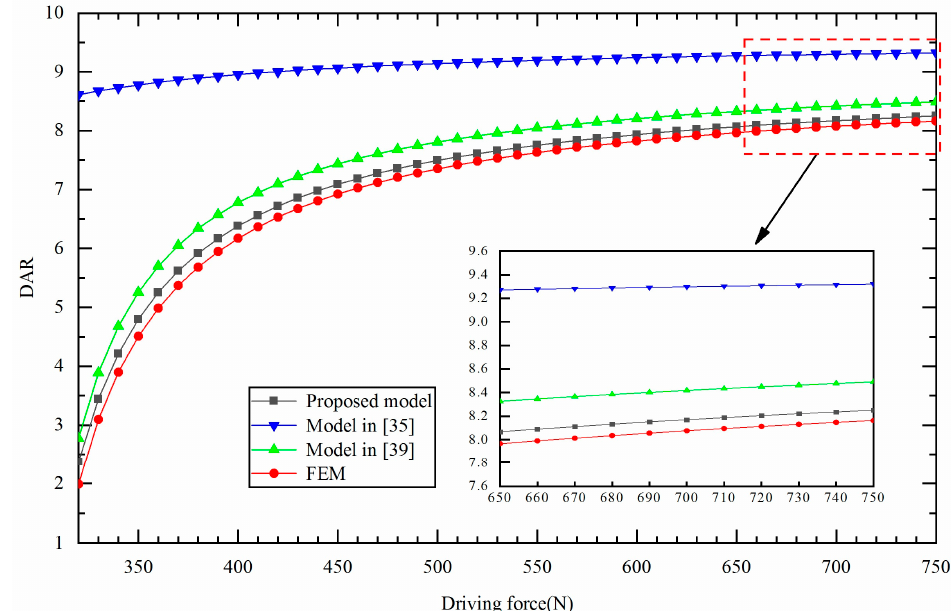
Figure 4. The changes in DAR with varied driving forces.